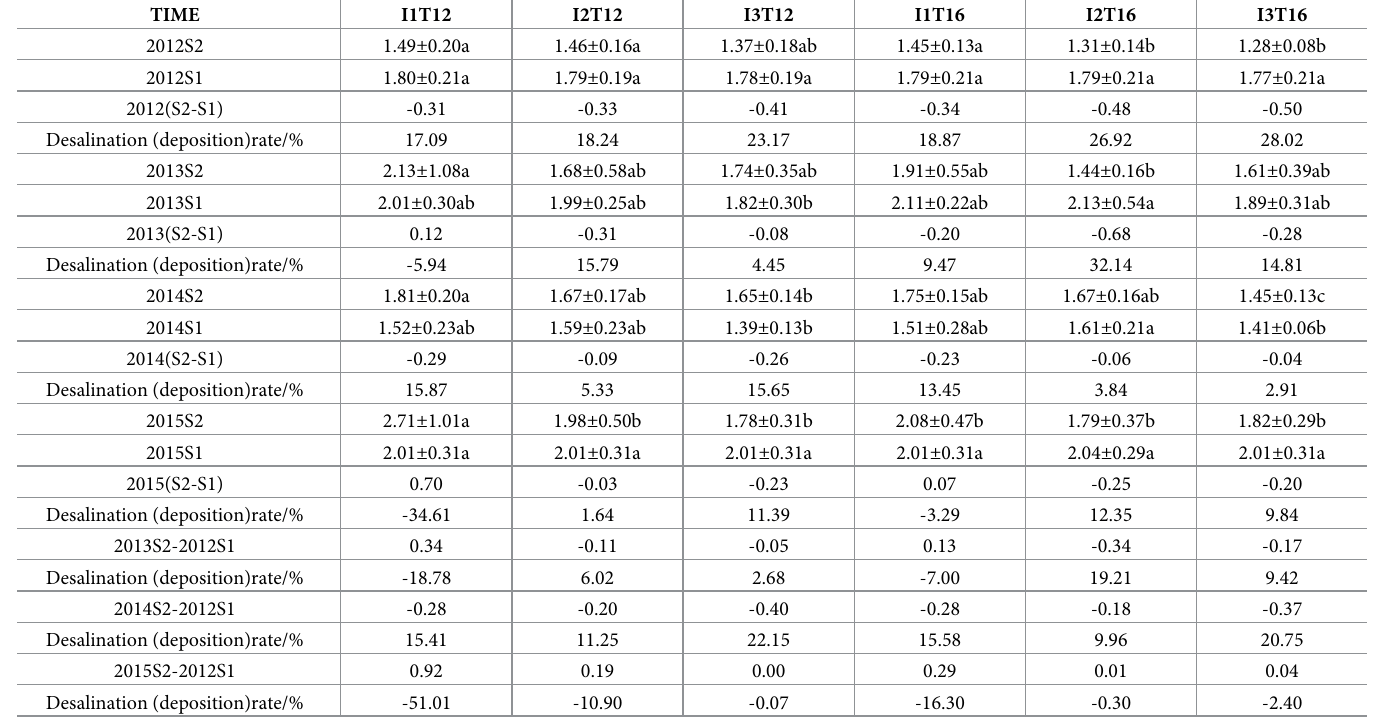
Table 3. Soil salt content(g/kg) of 0-100cm for cotton drip irrigation under mulch in